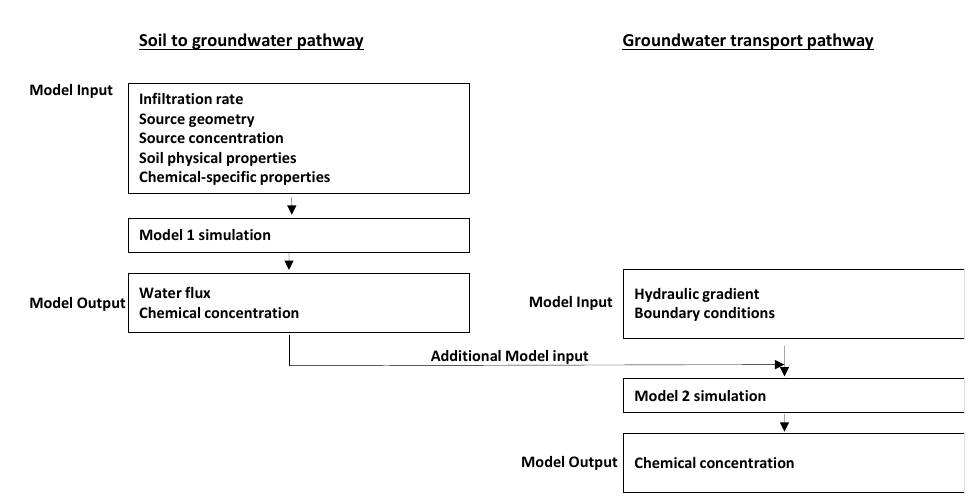
Figure 2. Schematic diagram for a contaminated site considering fate and transport in the unsaturated zone and the satu- rated aquifer underneath the source zone.